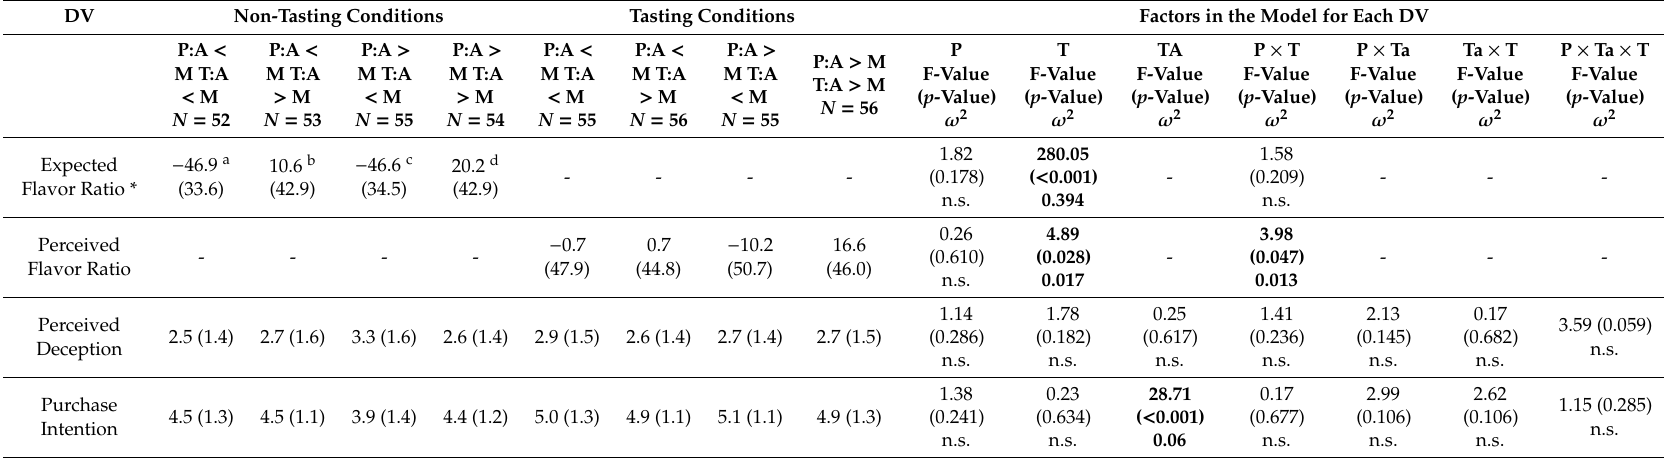
Table 3. ANOVA table with the mean (SD) for each condition on the dependent variables (DVs) including F-values with corresponding significance levels and e ff ect sizes for the main and all possible two- and three-way interaction e ff ects of pictorial (P), textual (T), and tasting (TA). Whenever a respondent had an expected flavor ratio greater (smaller) than zero, this means the participant expected the apple flavor to be more (less) intense compared to the mango flavor of the juice. DV Tasting Conditions Factors in the Model for Each